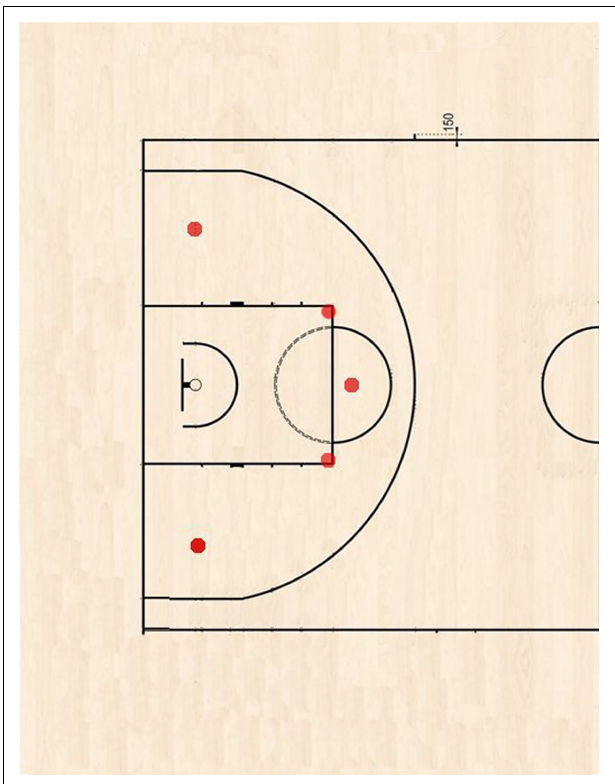
FIGURE 1 | Jump-shot spots placement on